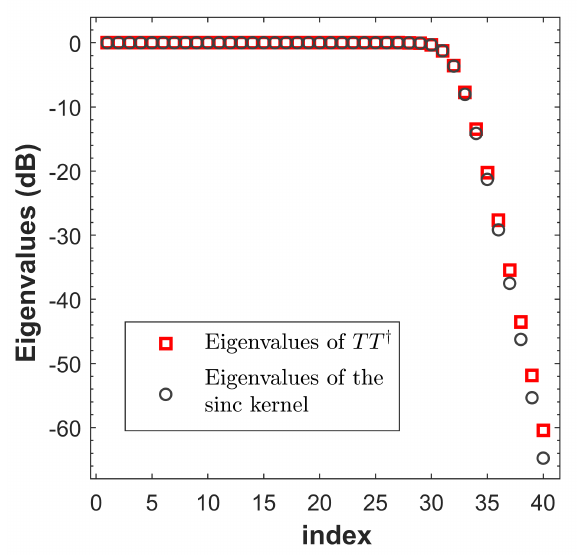
Figure 6. Comparison between the eigenvalues of T T † and those of the integral operator with the sinc kernel (19). The figure refers to the case a = 10 λ , X o = 10 λ , z o = 5